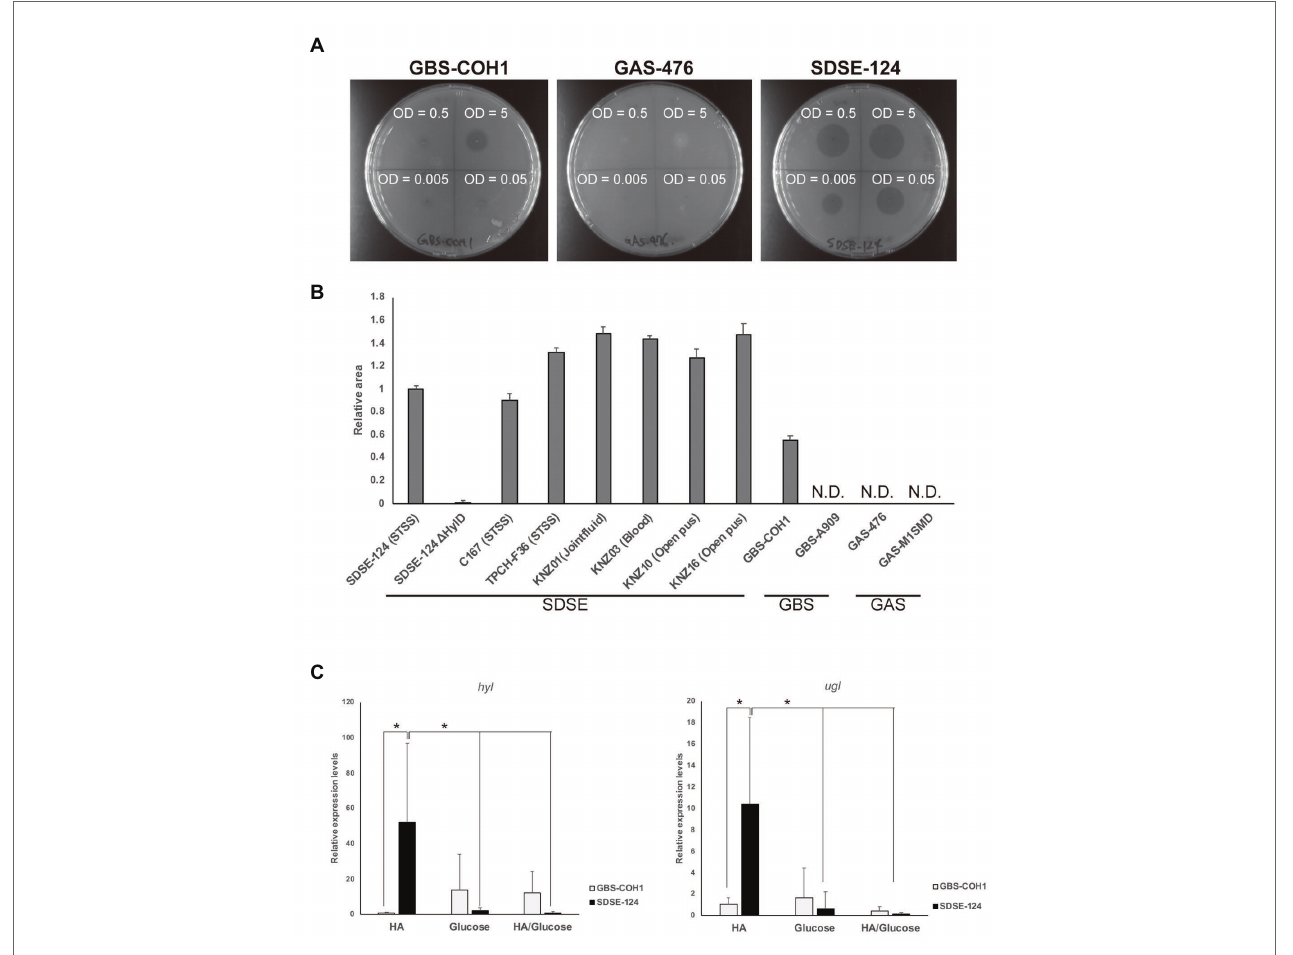
FIGURE 2 | Hyaluronate degradation. (A) Hyaluronate degradation on agar plates. GAS-476, GBS-COH1, and SDSE-124 were grown on brain-heart infusion (BHI) medium overnight and resuspended in fresh BHI at the indicated OD 600 . One microliter of each bacterial solution was spotted on hyaluronate-containing agar plates. By soaking the plates with 2 N acetic acid, degraded hyaluronate was detected around the bacterial spots after overnight culture. (B) Relative area after spotting 1 μ l of OD 600 = 0.5 solution followed by overnight culture. The areas were measured using Image J software. (C) Quantitative evaluation of hyl and ugl gene expression after 6 h of incubation in 0.4 mg/ml hyaluronate (HA)- and/or 10 mg/ml glucose-containing medium without agar. The average and standard deviation were calculated from three separate experiments performed in quadruplicate. Data were normalized to expression levels of the mutS gene. Relative expression levels were calculated as 1 using the averages of the hyl and ugl expression of GBS-COH1 in HA-containing medium. Values of p were calculated using Student’s t -test; * p <